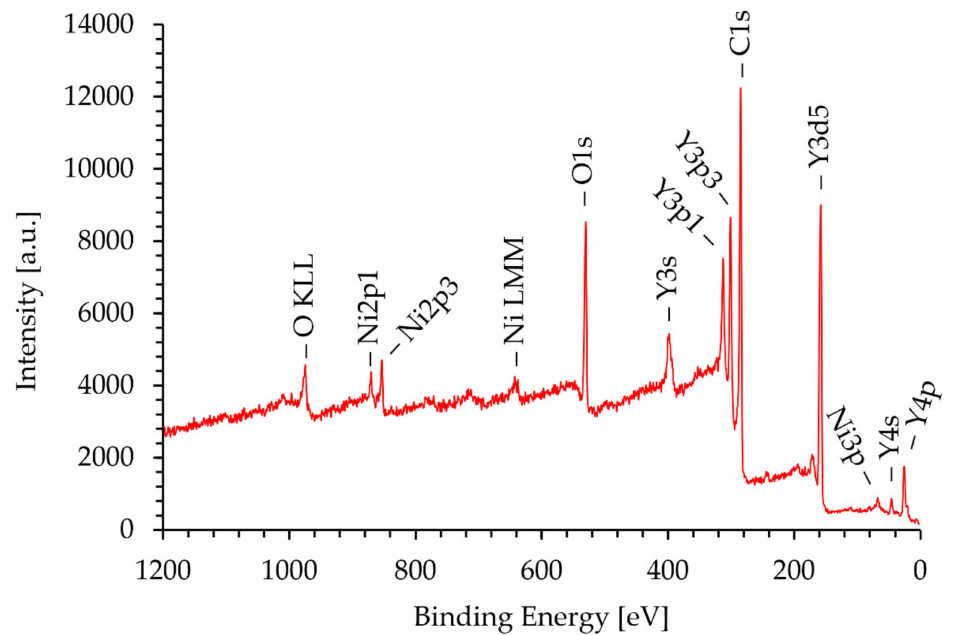
Figure 9. XPS spectrum of the concentrated sample Ni/Y 2 O 3 -0.025/0.100 after removal of a 10 nm thick surface layer.